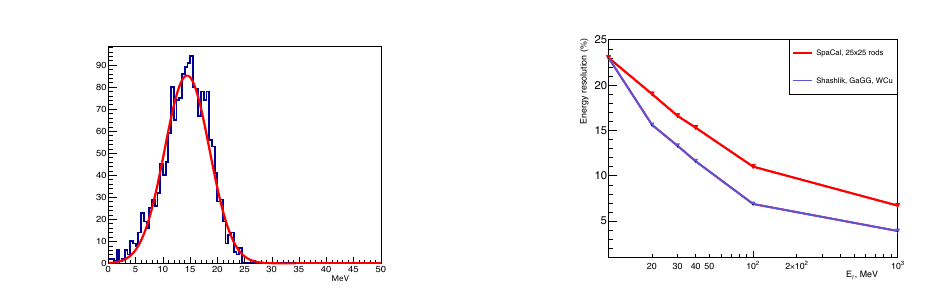
Figure 4. The left panel: spectrum of the energy release in “shashlik” (E γ = 30 MeV). The right panel: the energy resolution in the“spaghetti” (the red line) versus the “shashlik” (the blue line) calorimeters.